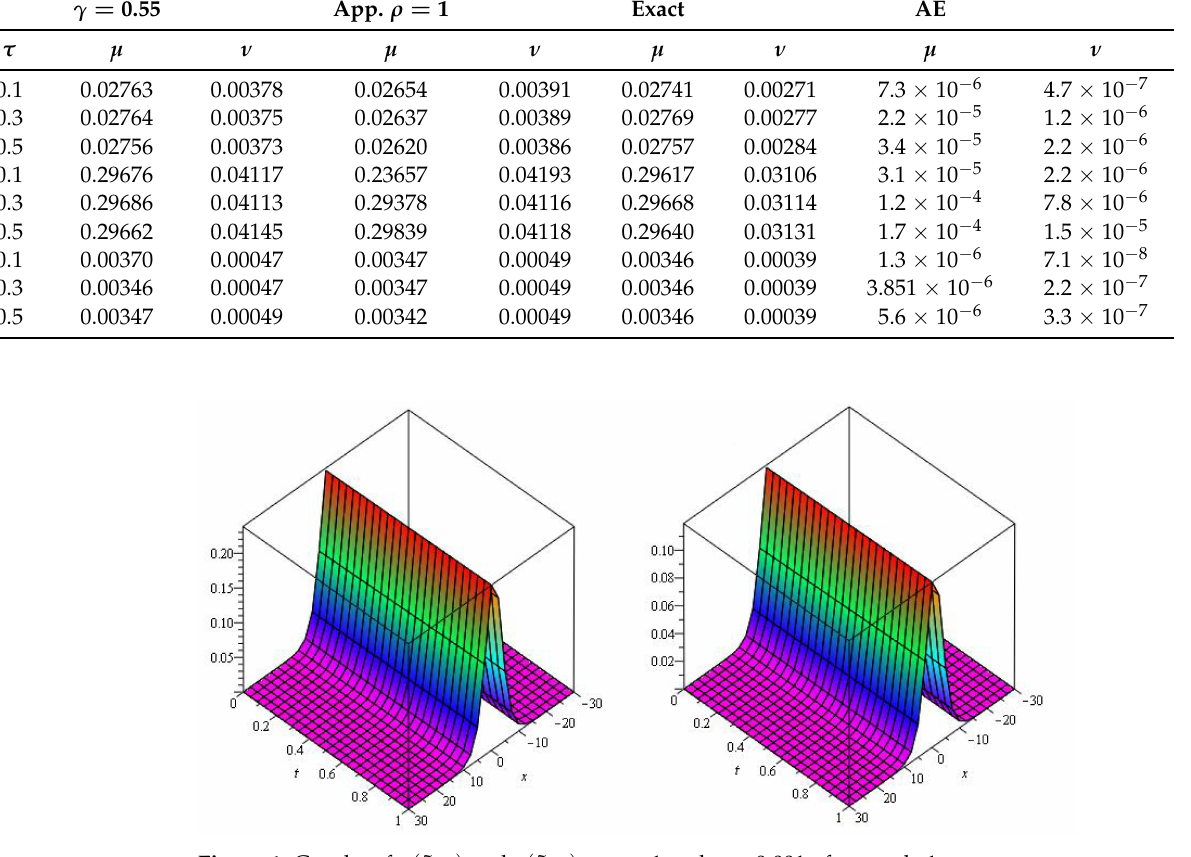
Figure 1. Graphs of µ ( ζ , τ ) and ν ( ζ , τ ) at ρ = 1 and η = 0.001 of example 1.